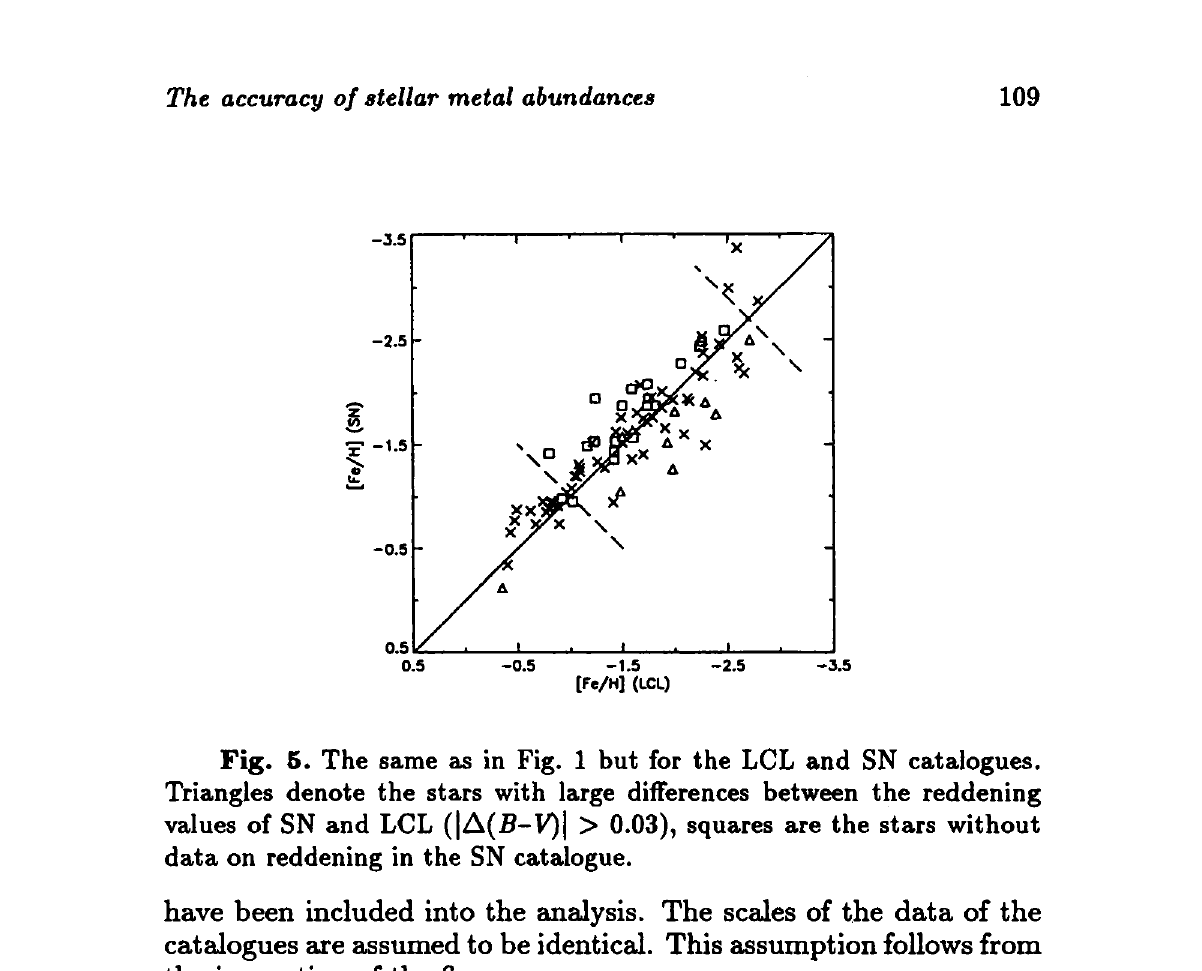
Fig. 5. The same as in Fig. 1 but for the LCL and SN catalogues. Triangles denote the stars with large differences between the reddening values of SN and LCL (|A(fl-V)| > 0.03), squares are the stars without data on reddening in the SN